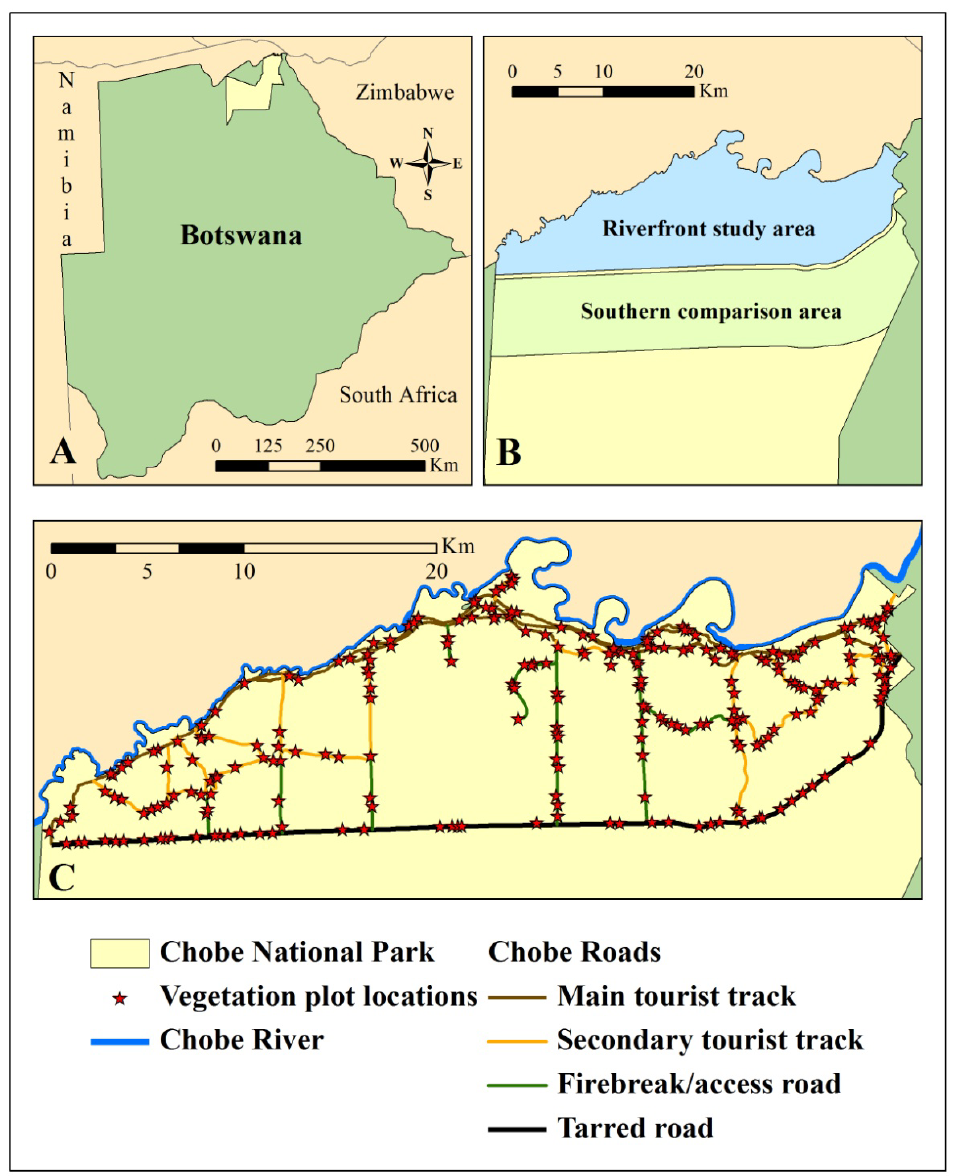
Figure 1. Chobe National Park lies in the northeast corner of Botswana ( A ). The utility of the Moving Standard Deviation Index (MSDI) for identifying elephant impacts was assessed primarily along the Chobe riverfront, which was compared to an area of lower elephant utilization to the south ( B ). Elephant utilization of vegetation was assessed in 257 vegetation plots along the Chobe riverfront ( C ). Sampling was constrained to utilize roads and tracks due to the prevalence of wildlife in the park. Main tourist tracks are dirt tracks heavily utilized by tourists many times each day. Secondary tourist tracks experience moderate usage by tourists. Firebreaks and access roads are not open to the public and are rarely utilized. The tarred road is highly utilized by vehicles. All points were constrained to be at least 50 m from the tarred road to avoid negative influences of this